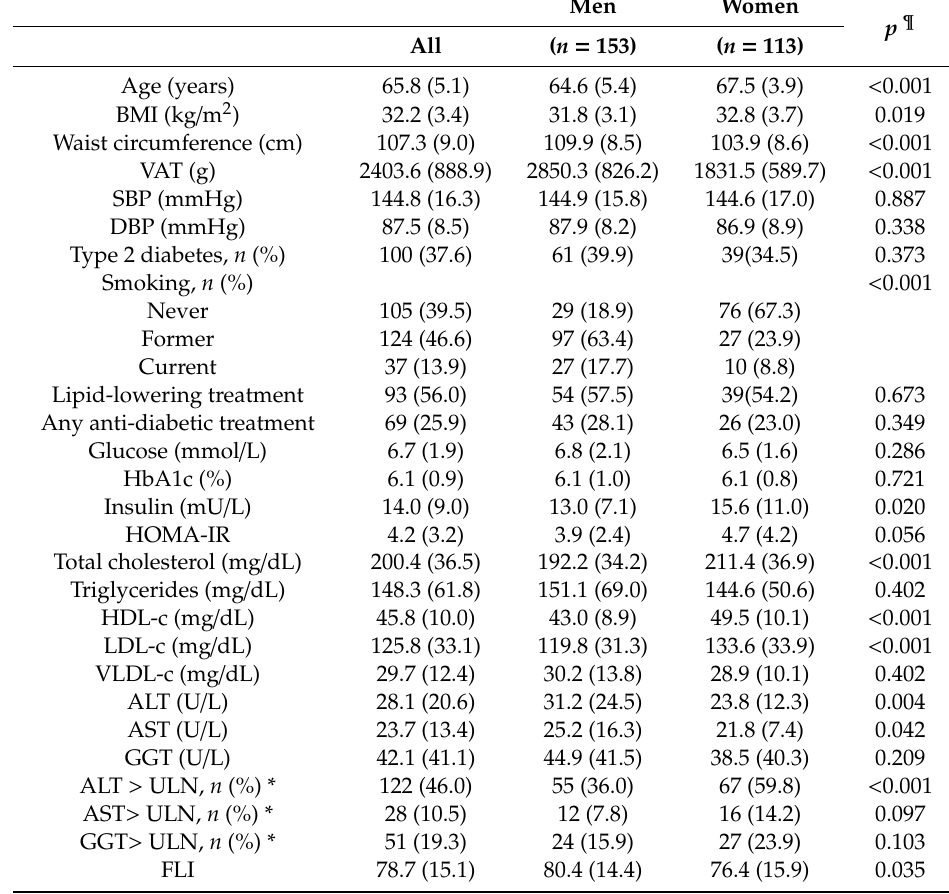
Table 1. Sociodemographic, clinical and liver characteristics of study participants diagnosed with MetS by sex at